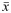
Statistics of Pollock’s painting action.(A) Histogram of the hand speed, Uhand; (B) histogram of the height of the hand from the surface of the canvas, H; histogram of the loading speed, Uload. The histograms are normalized such that the integral over the frequencies is unity. The vertical solid lines show the mean values in each case x¯x. The vertical dashed lines to the right and left of x¯ represent x¯+σx and x¯−σx, respectively, where σx is the standard deviation.